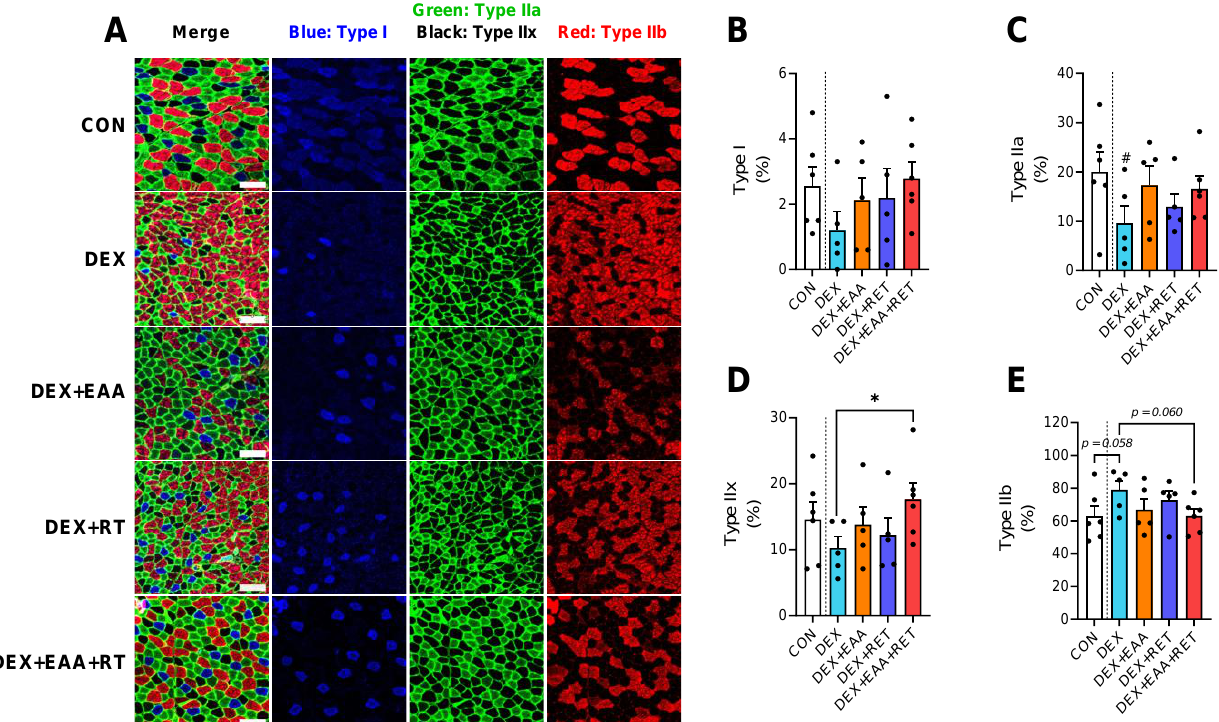
Figure 4. Combined treatment of EAA and RET prevents muscle fiber type shifting to fast glycolytic fiber due to DEX. ( A ) Representative image of immunofluorescence in gastrocnemius muscle for the triple-labeling with MHC type I (blue), MHC type IIa (green), MHC type IIx (black), and MHC type IIB (red). Scale bar, 100 μm (n = 5 – 6). ( B ) The proportion of MHC type-I-specific fibers (n = 5 – 6). ( C ) The proportion of MHC type-IIa-specific fibers (n = 5 – 6) ( D ) The proportion of MHC type-IIx-specific fibers (n = 5 – 6). ( E ) The proportion of MHC type-Iib-specific fibers (n = 5 – 6). Data are presented as mean ± S.E. # Significant difference from control group ( p < 0.05). * Significant difference between labeled groups ( p < 0.05). CON, sedentary control; DEX, dexamethasone; EAA, essential amino acids; RET, resistance exercise training; MHC, myosin heavy chain.